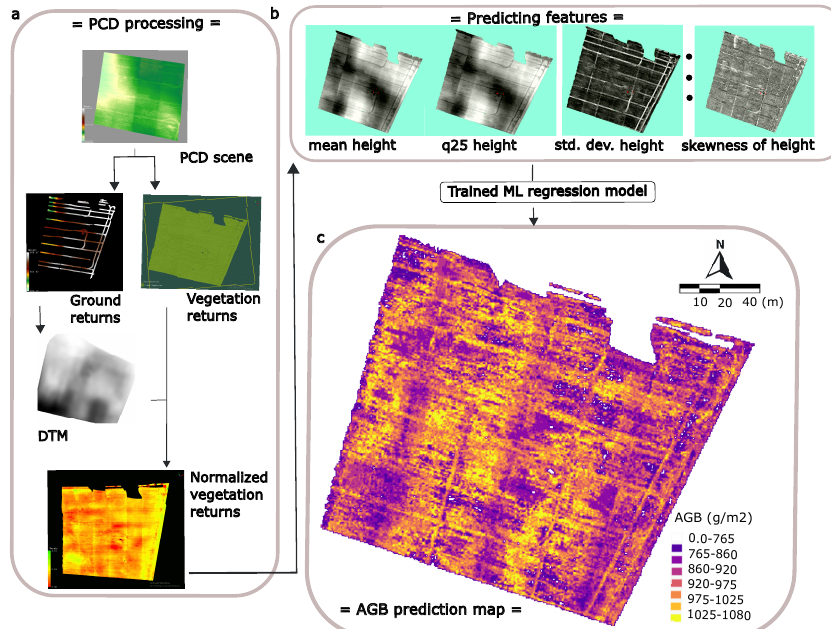
Figure 8. The processing pipeline from the input PCD scene to the output AGB prediction map (in g/m 2 at a 1 m 2 resolution): ( a ) the PCD scene processing, including binary classification and digital terrain model (DTM) generation via the interpolation of ground returns; ( b ) a normalized point cloud with height values that were relative to the ground was used to produce the prediction feature maps for the metrics of height and reflectance; ( c ) the predictors were input into the trained ML regression model to produce the AGB prediction maps. The example AGB map corresponds to the barley field on 8 July